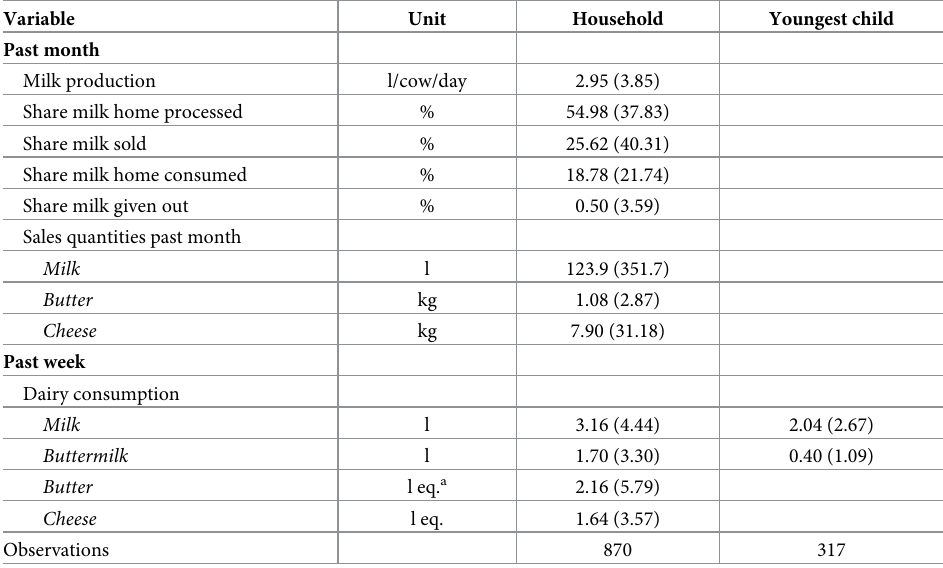
Table 4. Descriptive statistics of outcome variables used in analysis of milk producer adaptation strategies and